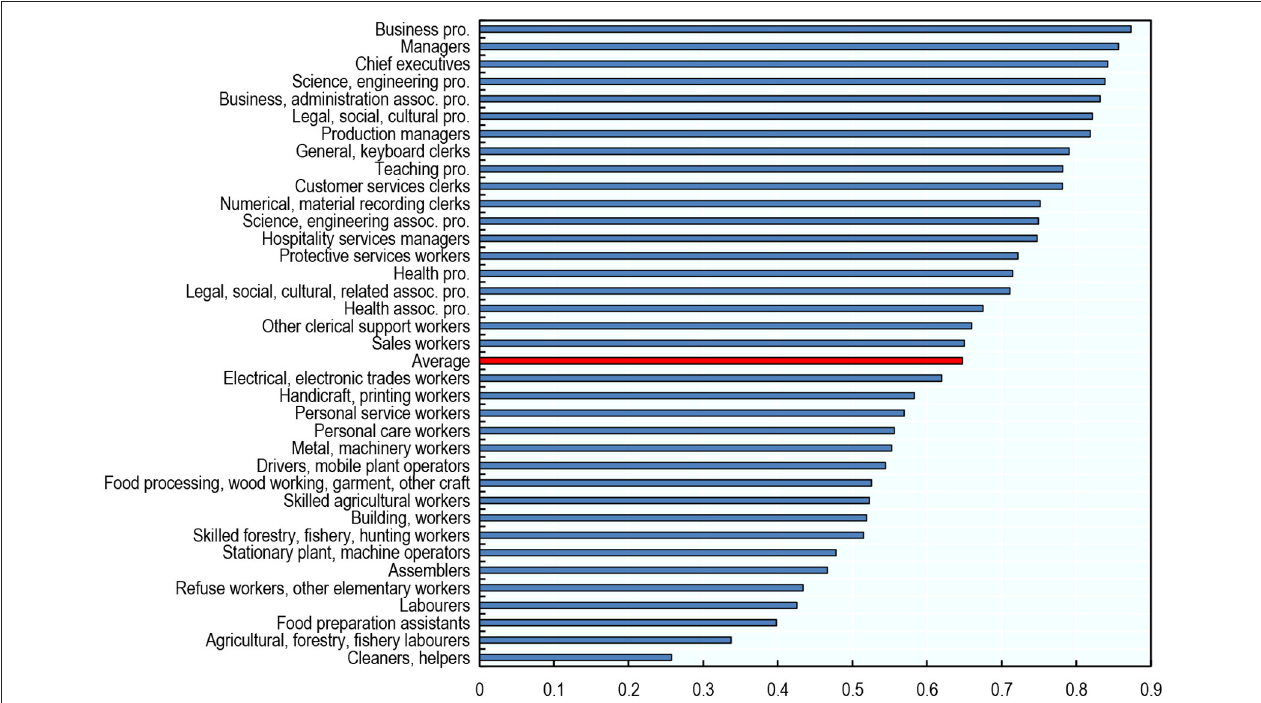
FIGURE 4 | Highly educated white-collar occupations are among the occupations with the highest exposure to AI. Average exposure to AI across countries by occupation, 2012. The averages presented are unweighted. Cross-country averages are taken over the 23 countries included in the analysis. Authors’ calculations using data from the Programme for the International Assessment of Adult Competencies (PIAAC) and Felten et al.